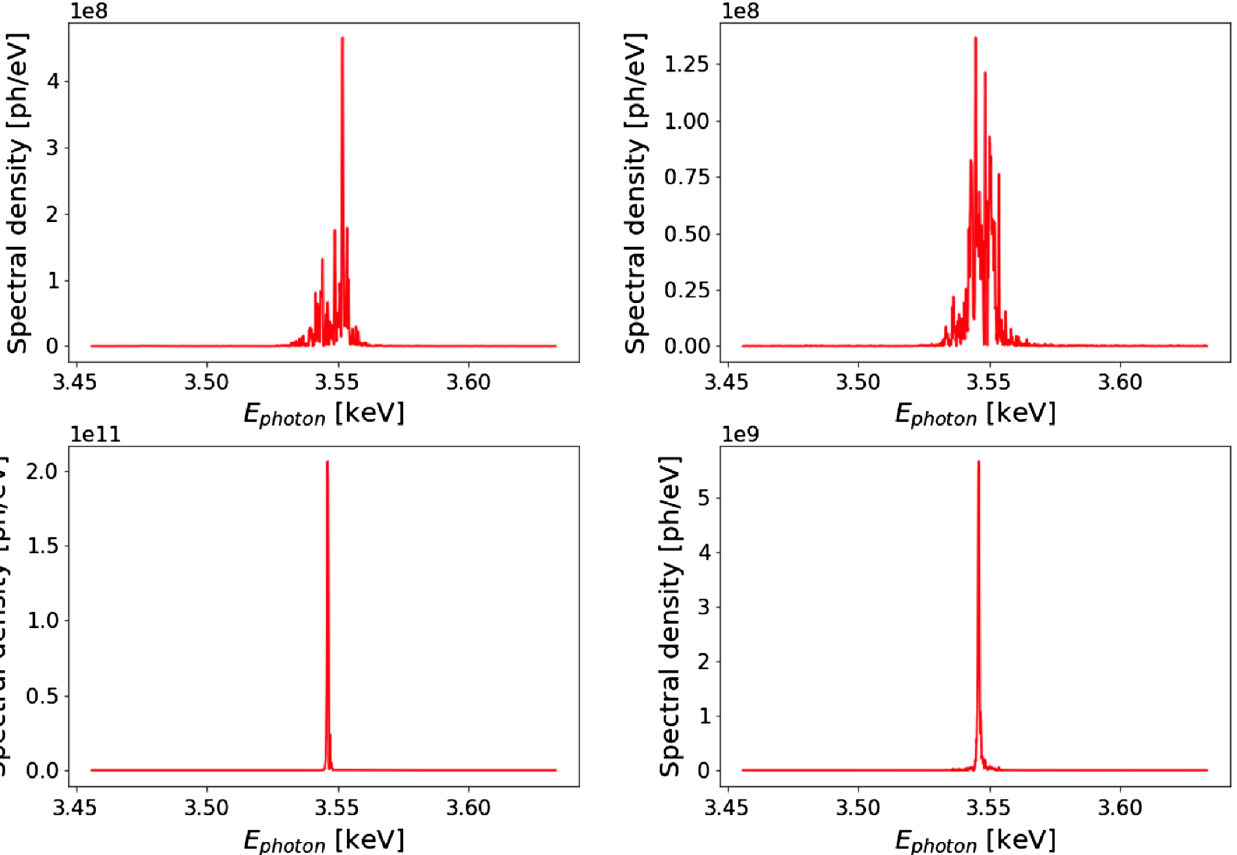
FIG. 13. Comparison between SNR in the two-chicane and in the one-chicane case. On the left we show the on-axis spectral density of one SASE pulse realization (left top) and the corresponding seeded case (left bottom) for the two-chicane setup just before the final radiator. In this case SNR ≃ 500 . On the right we show the on-axis spectral density of another SASE pulse realization (right top) and the corresponding seeded case (right bottom) for the one-chicane setup at the maximum SNR point (around 25 m, see Fig. 14). In this case SNR ≃ 50 . The gain in SNR is about a factor of